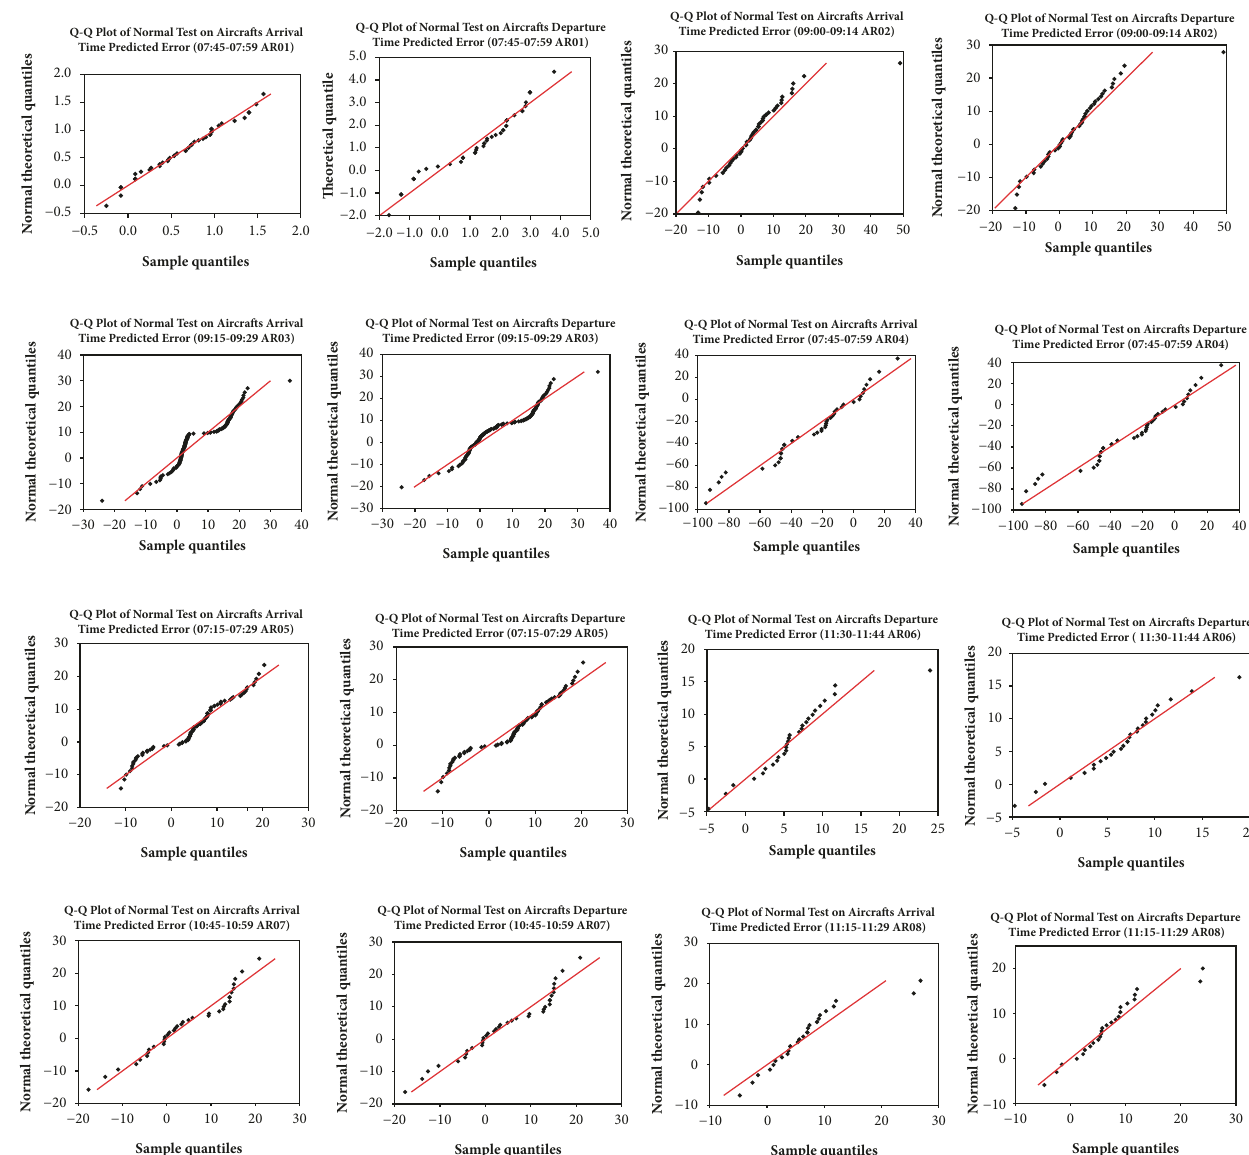
Figure 8: Q-Q plots of normal test on aircraft’ arrival / departure time predicted